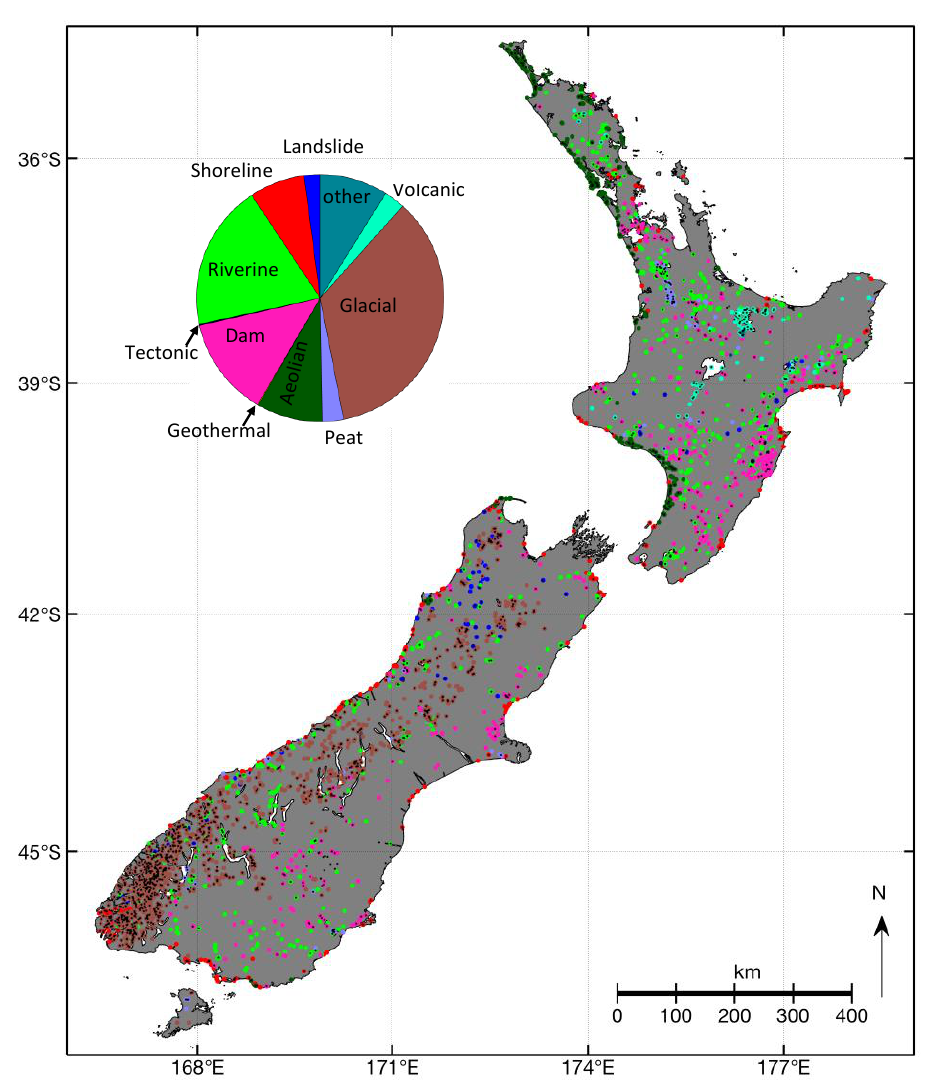
Figure 2. Map of New Zealand showing the locations of 3820 lakes according to the Freshwater Ecosystems of New Zealand (FENZ) geodatabase [27]. The colour of the dots identifies the geomorphic lake type as per the labels of the pie chart. The pie chart shows the relative distribution of lake types.